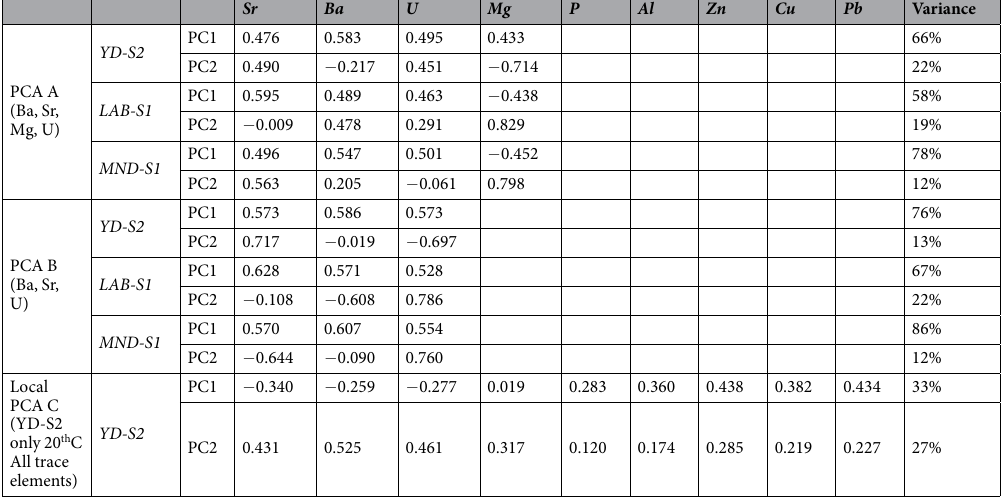
Table 3. Summary of the trace element loadings for all the PCA combinations used. PCA A and B are used in the chronology building section, while local PCA C is used for the interpretation of the soil vs. bedrock signal in the YD-S2 extreme events section.